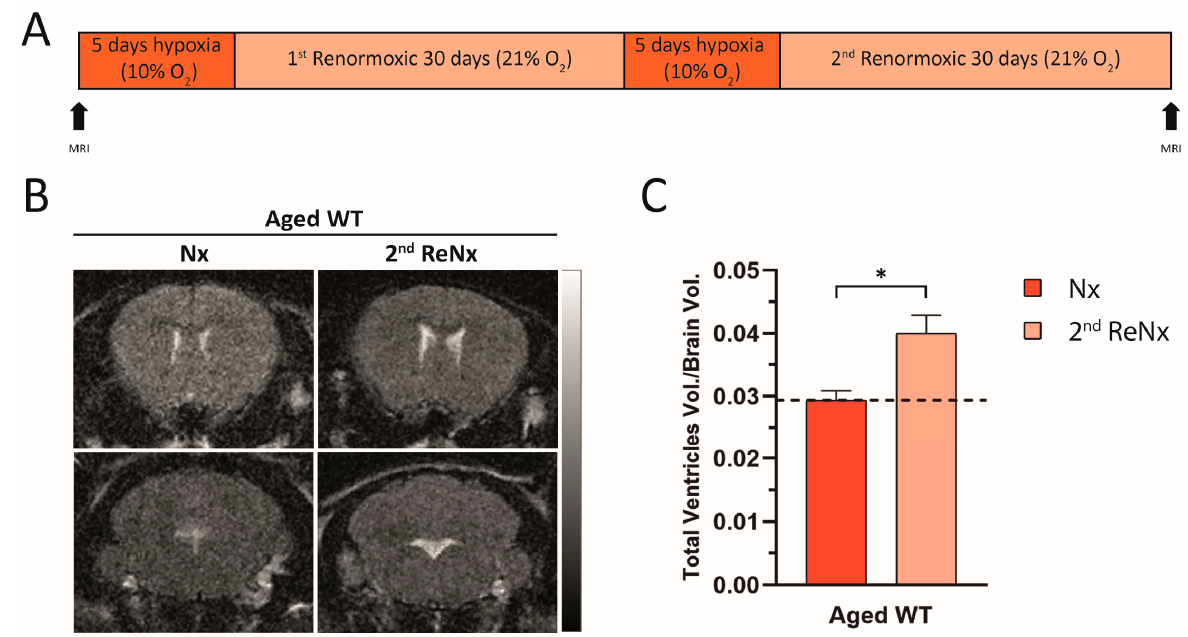
Figure 6. Consecutive hypoxic events produce permanent ventriculomegaly. ( A ) Schedule showing the experimental protocol. Briefly, aged wt mice were subjected to two consecutive cycles of Hx-ReNx, in which the Hx period consisted of 5 days at 9% O 2 and the ReNx period consisted of 30 days at 21% O 2 . ( B ) Representative images of MRI coronal sections at the two time points analyzed, before the start of the Hx-ReNx cycles (Nx) and at the end of the treatment (second ReNx). The gradient scale of T2-weighted MRI indicates the liquid present in the tissue, ranging from bright (high water content) to dark (absence of water). ( C ) Quantification of brain ventricular volume under the conditions described in ( A ). Data are represented as mean ± SEM, The number of animals tested was n = 4, * p < 0.05.